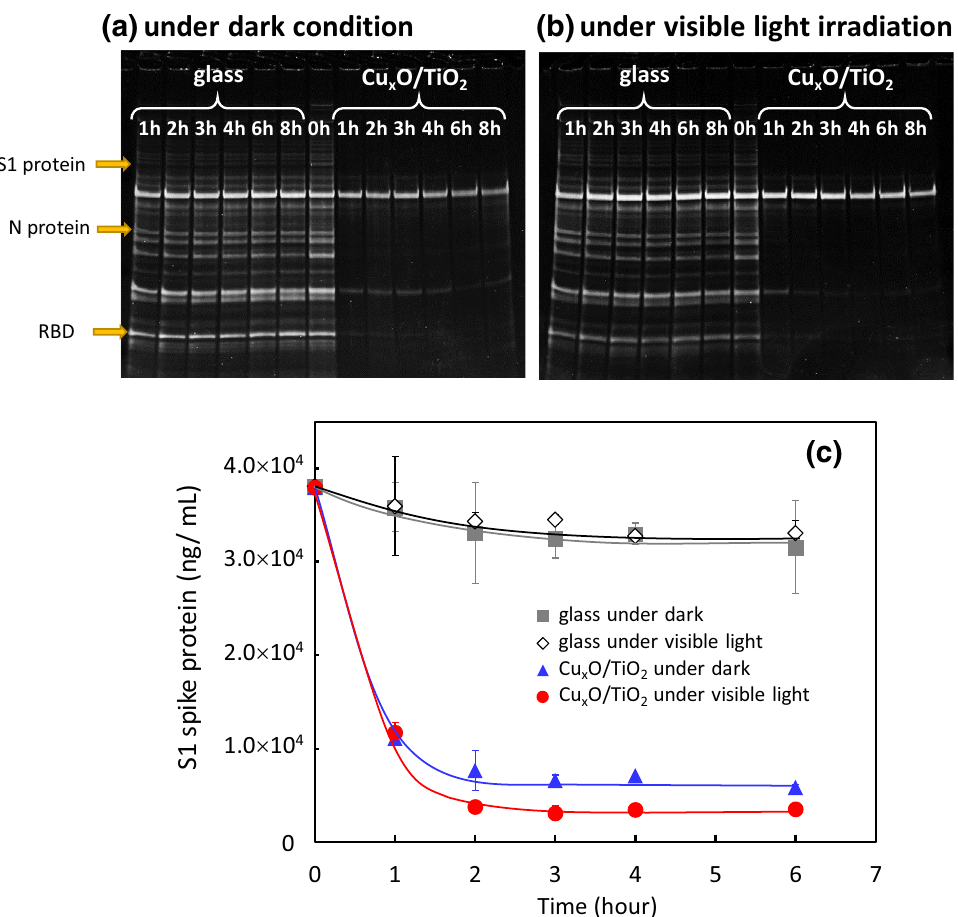
Figure 4. Analysis of SARS-CoV-2 proteins by SDS-PAGE and ELISA. SARS-CoV-2 proteins under ( a ) dark condition and ( b ) visible light irradiation condition for glass substrate and Cu x O/TiO 2 photocatalyst were separated by SDS-PAGE. Lanes 0 h, 1 h, 2 h, 3 h, 4 h, 6 h, and 8 h corresponded to the time after the reaction, respectively. ELISA results ( c ) on SARS-CoV-2 spike S1 protein concentration under dark condition and visible light irradiation condition for glass substrate and Cu x O/TiO 2 photocatalyst. Visible light irradiation was conducted using a white fluorescence bulb passed through a UV cutoff filter with the light intensity of 1000